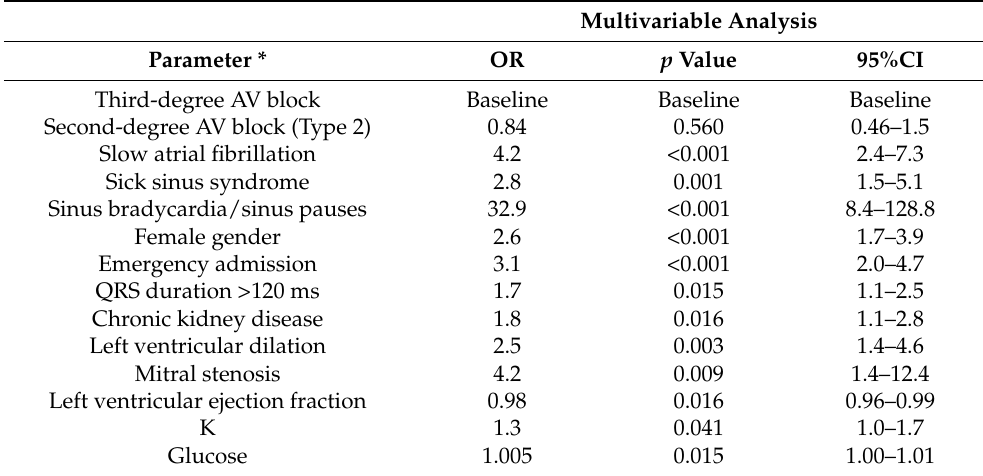
Table 4. Atrioventricular conduction disorders associated with beta-blocker use after adjusting for patient-dependent factors.